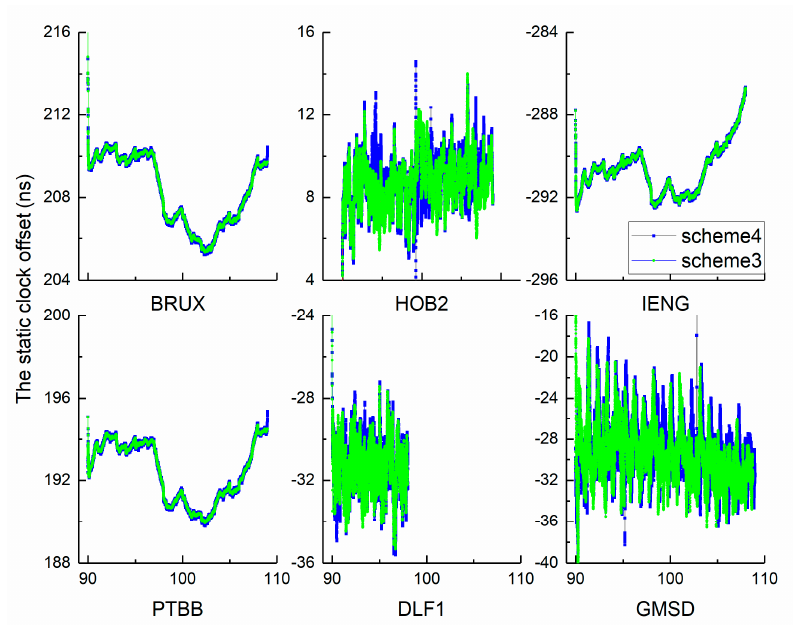
Figure 10. The static clock offset time series of GPS PPP.